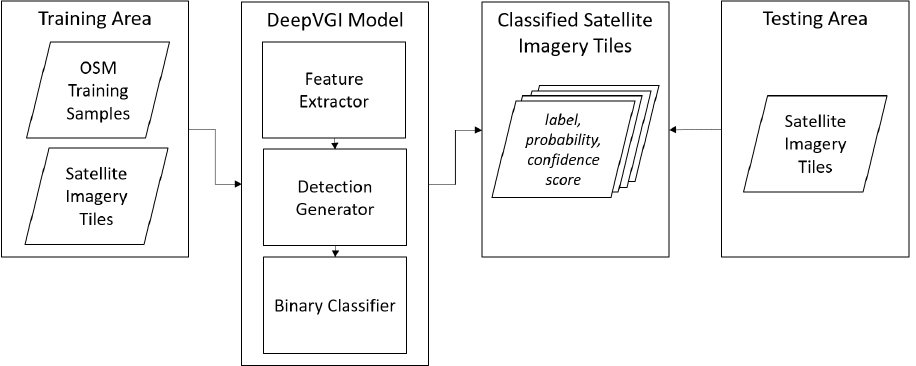
Figure 2. DeepVGI Workflow: The DeepVGI model is trained using building footprint sample from OpenStreetMap and satellite imagery tiles from Bing. For each tile in the testing area the model generates label, probability and confidence